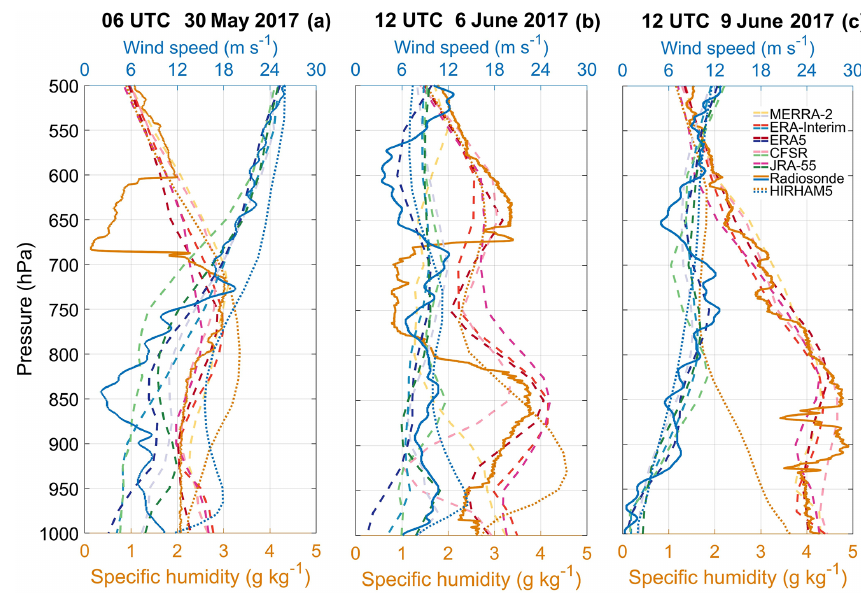
Figure 6. Vertical profiles of specific humidity (gkg − 1 , pink/orange colours) and wind speed (ms − 1 , blue/green colours) at Ny-Ålesund, based on radiosonde (solid lines), reanalyses (ERA-Interim, ERA5, CFSv2, JRA-55, and MERRA-2; dashed lines), and the HIRHAM5 model (dotted lines), during the 30 May event (a) , the 6 June event (b) , and the 9 June event (c) . Figure S8 shows the complete temporal evolution of the vertical profiles, and Figure S9 shows the bias and RMSE of each reanalysis and model compared to the radiosondes